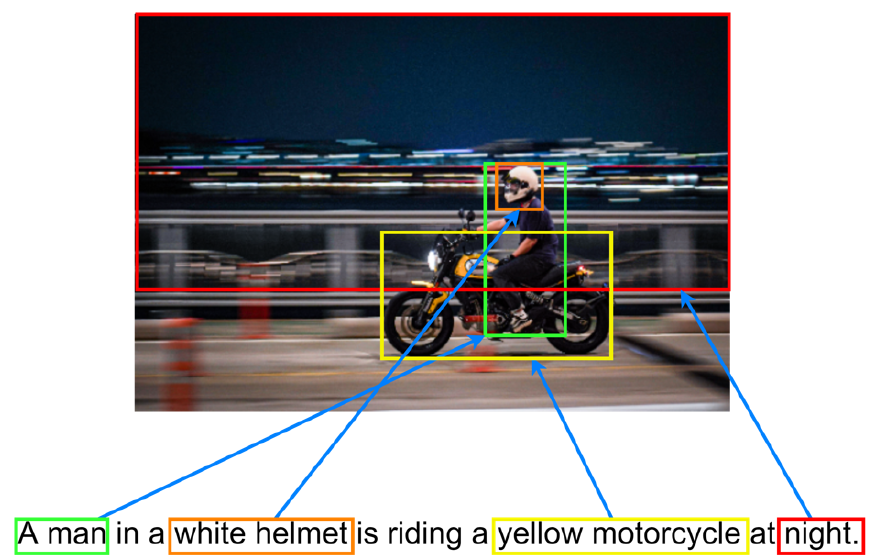
Figure 5. The relationship between the objects in the image and the keywords in the sentence.